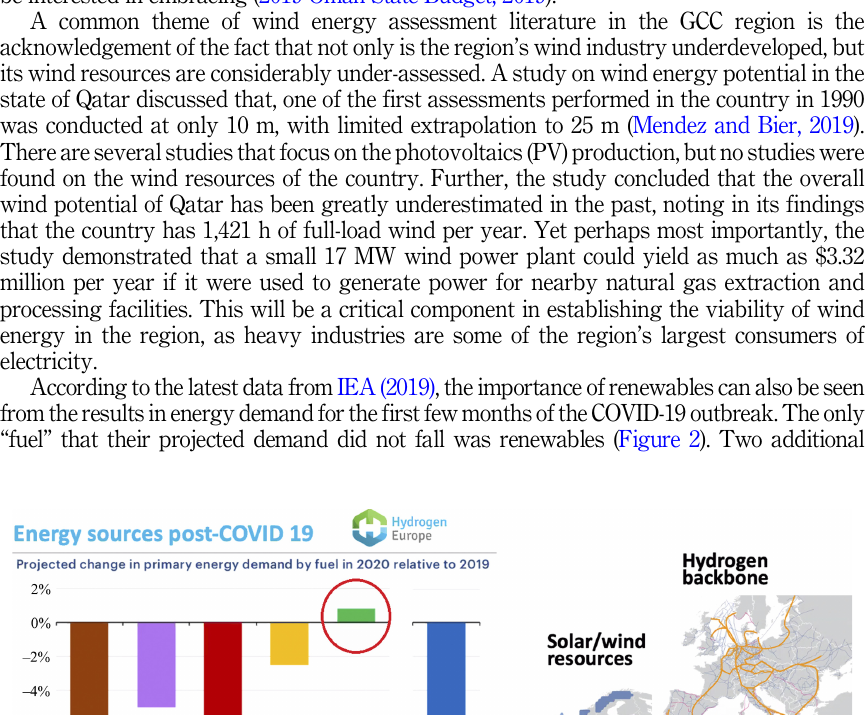
Figure 2. An opportunity for renewables and hydrogen growth